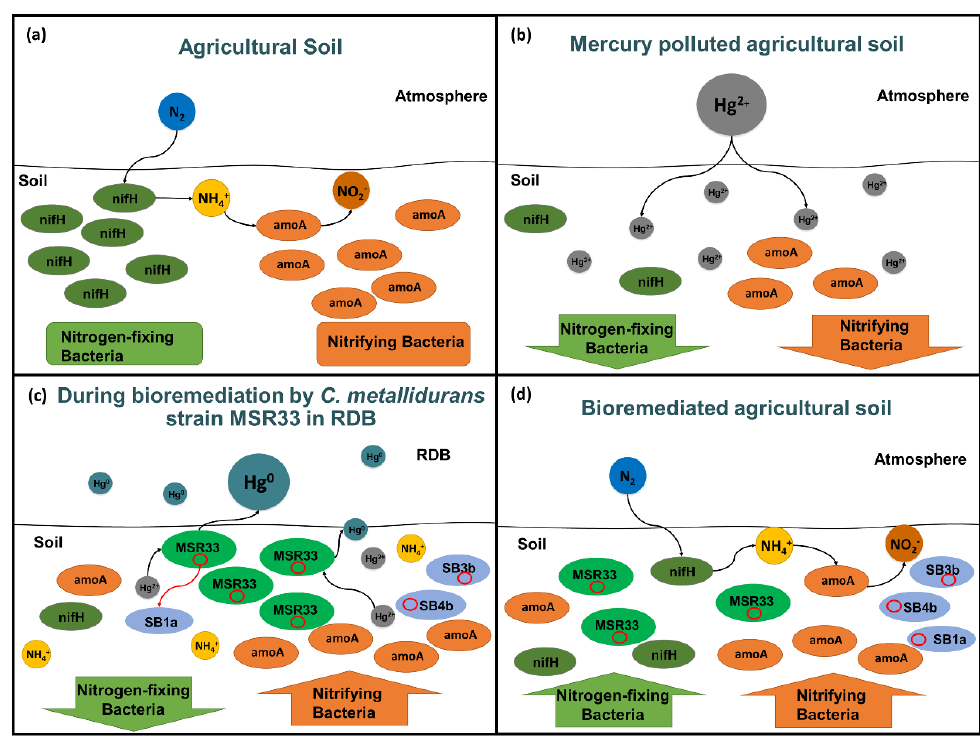
Figure 8. Overview of the effects of mercury and mercury bioremediation by C. metallidurans strain MSR33 of agricultural soil on nitrogen cycle microorganisms in rotary drum bioreactor (RDB). ( a ), Balance between nitrogen-fixing and nitrifying microorganisms in agricultural soil. ( b ), Inhibition of nitrogen-fixing and nitrifying microorganisms in agricultural soil exposed to mercury. ( c ), Imbalance between nitrogen-fixing and nitrifying microorganisms during mercury-polluted agricultural soil bioremediation by C. metallidurans strain MSR33 in RDB. ( d ), Re-establishment of nitrogen-fixing and nitrifying bacterial communities in mercury-remediated agricultural soil by C. metallidurans strain MSR33 in RDB. The plasmid pTP6 is represented in red circles on ( c ) and ( d ).